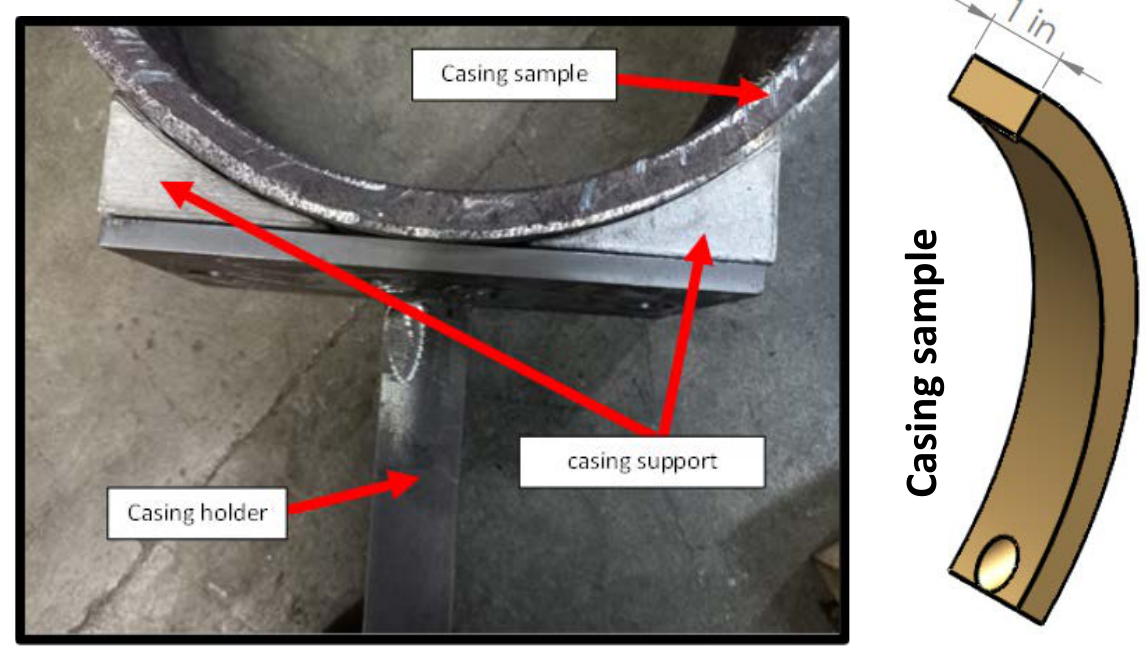
Figure 2. Casing holder and support assembly.